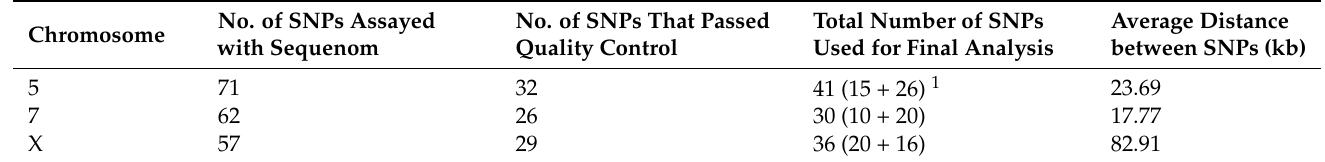
Table 2. Summary of SNP characteristics for different regions, genotyped using the Sequenom assay, before and after data cleaning and their combination with Ovine SNP50k BeadChip SNPs, for follow up